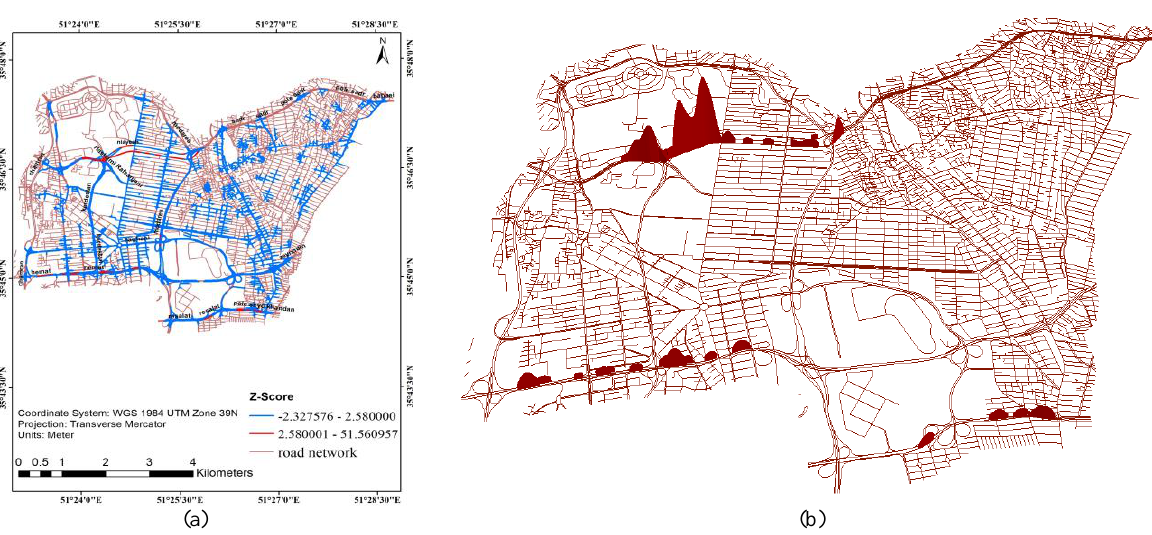
Figure 8. The vulnerability map of the accident-prone segments resulting from the integration of NKDE method (continuous kernel function) and Network-Constrained Getis-Ord Gi* statistics based on Z-Score at 99% confidence level (a) 2D (b)